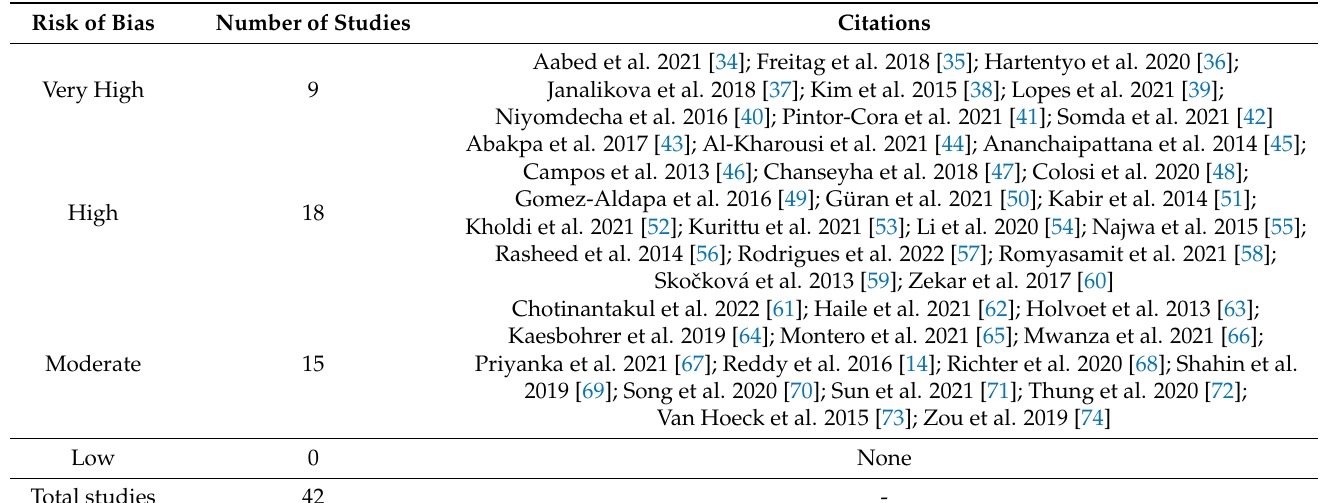
Table 1. Risk of Bias Assessment.